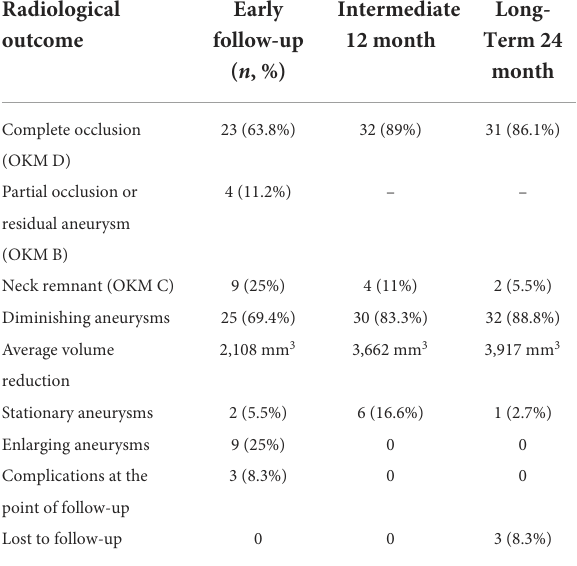
TABLE 2 Procedural and angiographic